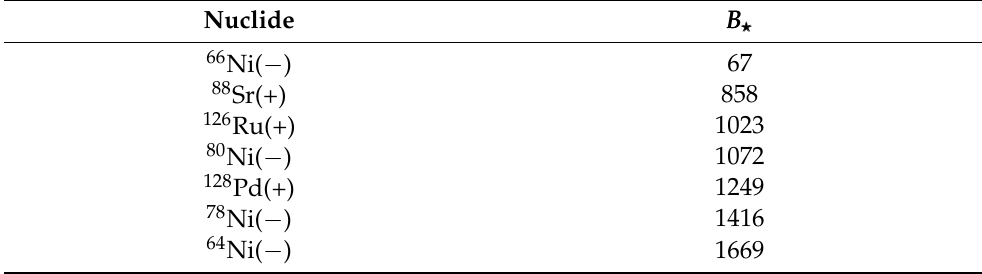
Table 1. Magnetic field strength B (cid:63) = B / B rel for the appearance (+) or the disappearance ( − ) of a nuclide in the outer crust of a